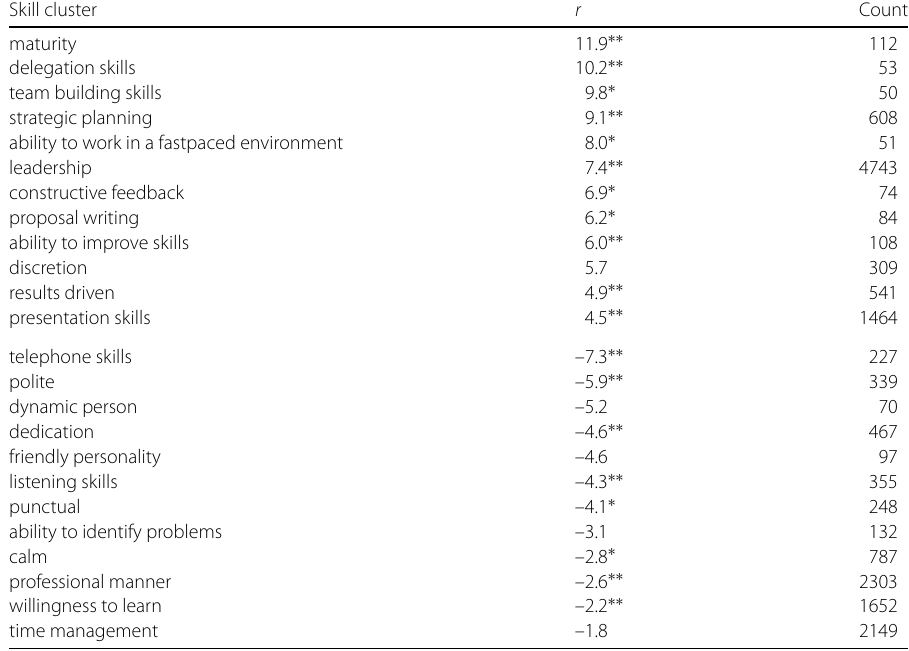
Table 2 Skills with the highest and the lowest overall salary rewards ( r from Eq. (2)) Skill cluster r Count